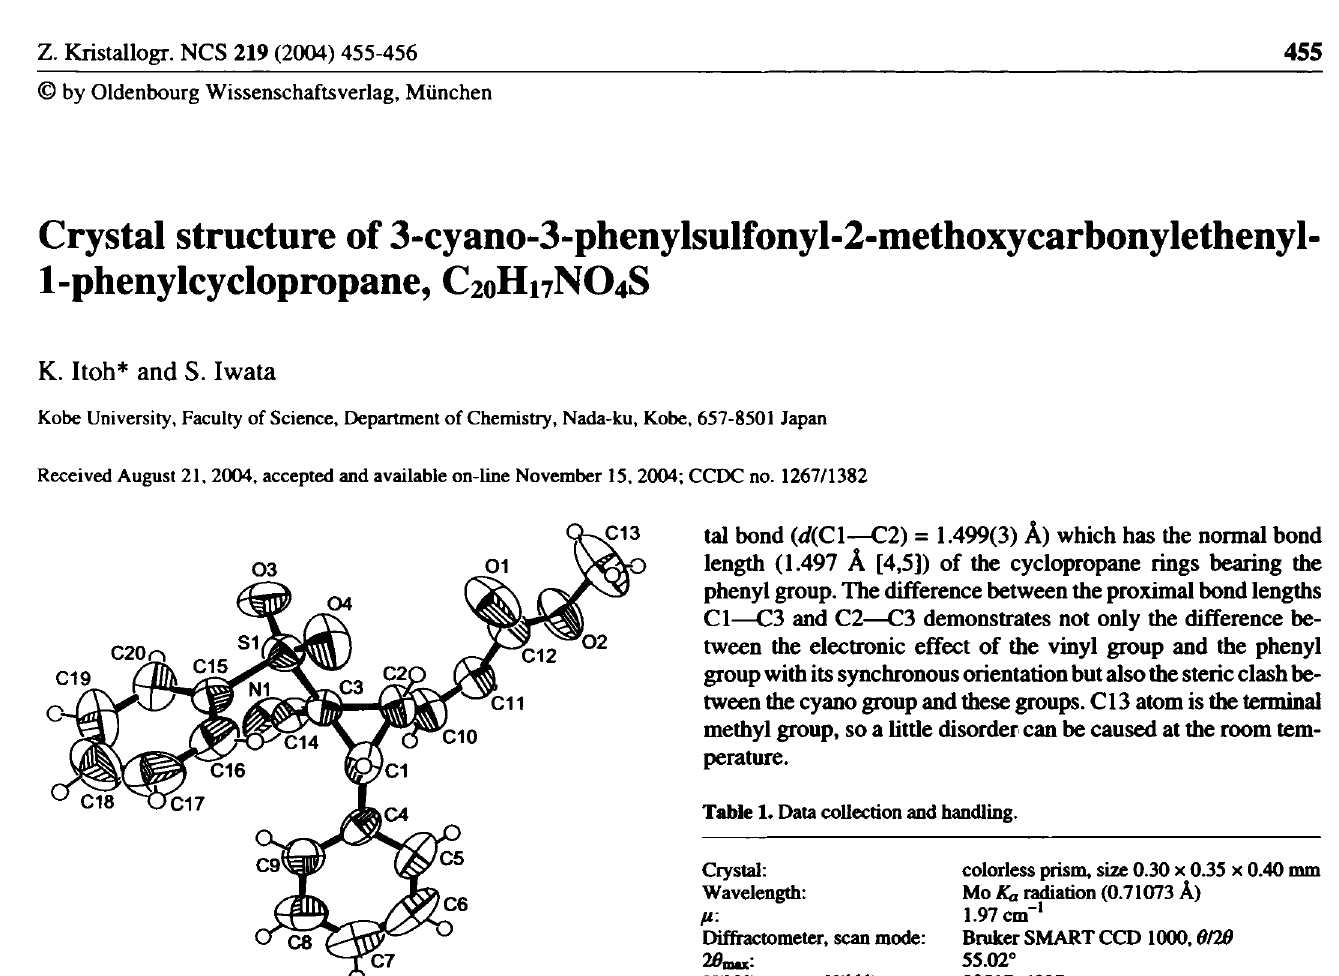
Table 2. Atomic coordinates and displacement parameters (in Â 2